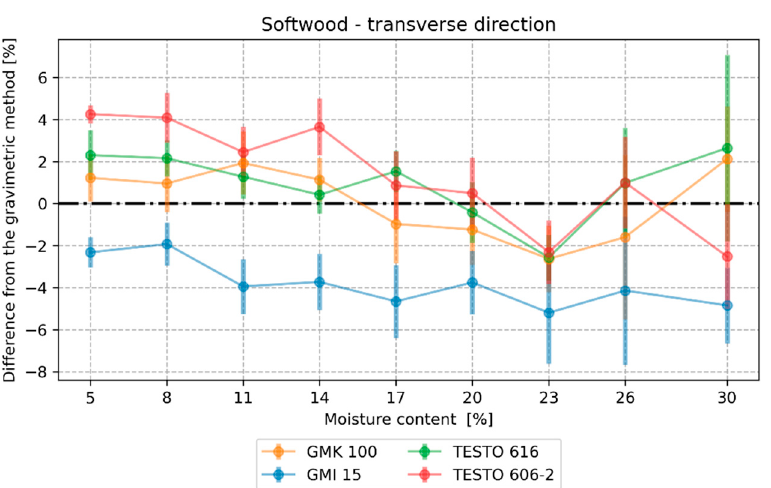
Figure 5. Comparison of average values of differences from the gravimetric method in the longitu- dinal direction of spruce wood using selected moisture meters GMI 15, GMK 100, Testo 616 and Testo 606-2 in different moisture conditions.